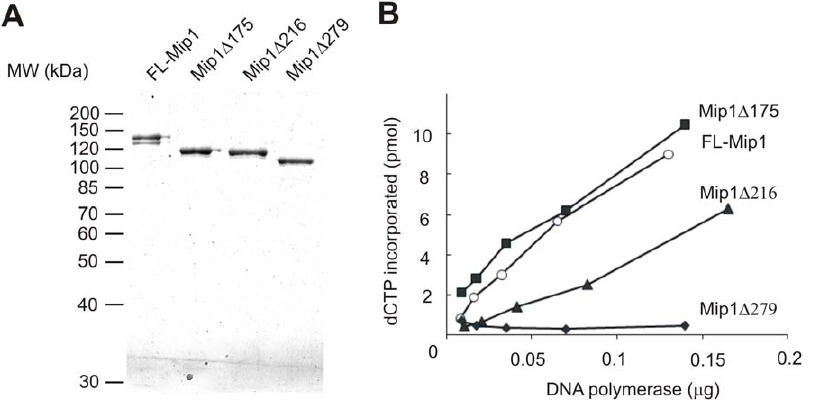
Figure 2. Purification and specific activity of the full-length and C-terminal deletion mutants of Mip1. A. Full-length and deletion mutants of Mip1 carrying N-terminal 6 6 His tag were overexpressed in E. coli and purified using Ni-affinity and S-Sepharose ion exchange chromatography. 0.3 m g of purified FL-Mip1 (141.0 kDa), Mip1 D 175 (120.7 kDa), Mip1 D 216 (115.9 kDa) and Mip1 D 279 (108.4 kDa) were separated on 8% SDS-PAGE. B. Specific activity of FL-Mip1 and C-terminal deletion mutants was measured by incorporation of [ a - 32 P]-dCTP into calf thymus activated DNA. The activity of 8–165 ng of polymerase was measured in a 10 m l reaction in the presence of 50 m M dATP, dGTP and dTTP, 5 m M dCTP, 50 m g/ml activated calf thymus DNA and 1 m Ci of [ a - 32 P]-dCTP. Reaction products were spotted onto DE81 Whatman filter and washed with 0.5 M sodium-phosphate buffer pH 6.4. dCTP (pmol) incorporated in 30 min at 30 u C was calculated from the percentage of incorporated radioactivity and plotted against the protein concentration: FL-Mip1 – empty circle, Mip1 D 175 –filled square, Mip1 D 216 – filled triangle, Mip1 D 279 – filled diamond.